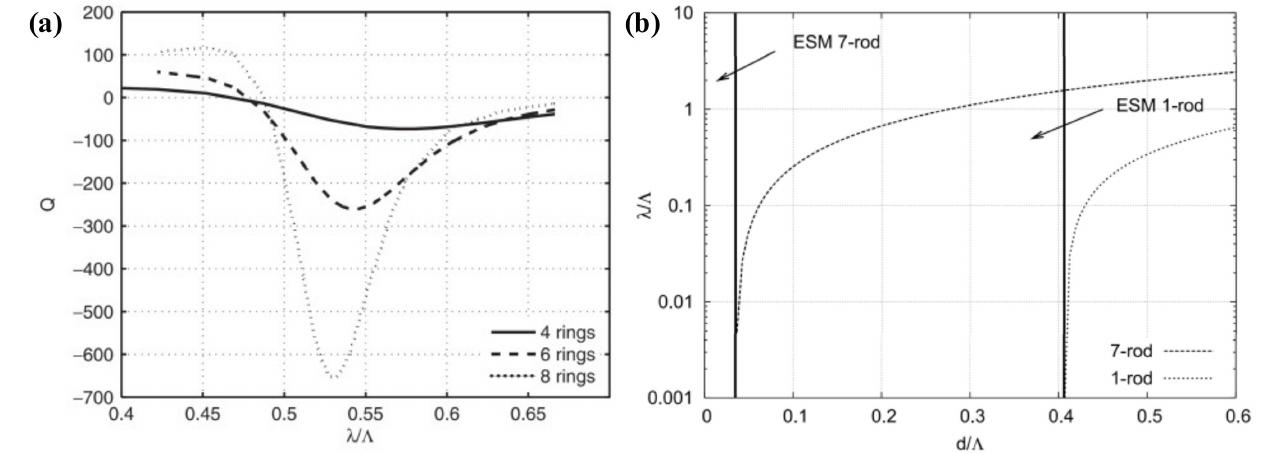
Figure 3. ( a ) Variation in the Q value with normalized wavelength λ */ Λ as the number of air hole rings varies [36]; ( b ) cutoff wavelength of fiber cores replacing 1 and 7 air hole PCFs [6]. Method two: Normalized cutoff frequency (V)